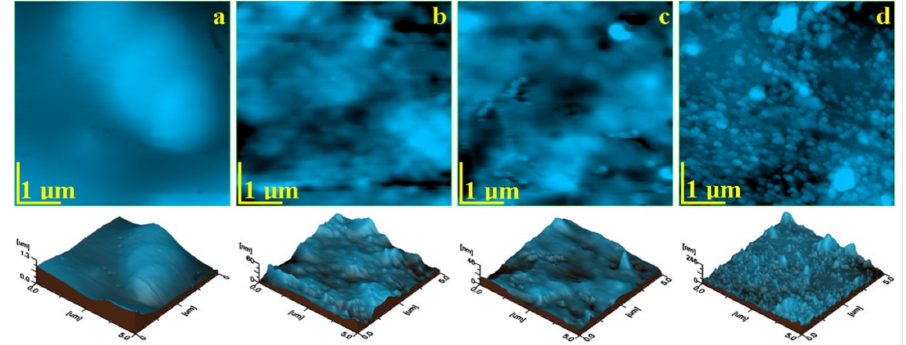
Figure 4. AFM topographic images of the initial samples’ surfaces: ( a ) Blugloo, ( b ) Light Bond, ( c ) Opal Seal, and ( d ) Experimental material C1. Three-dimensional images of each topographic image are given below. Table 3. Roughness values measured with AFM for the initial samples.